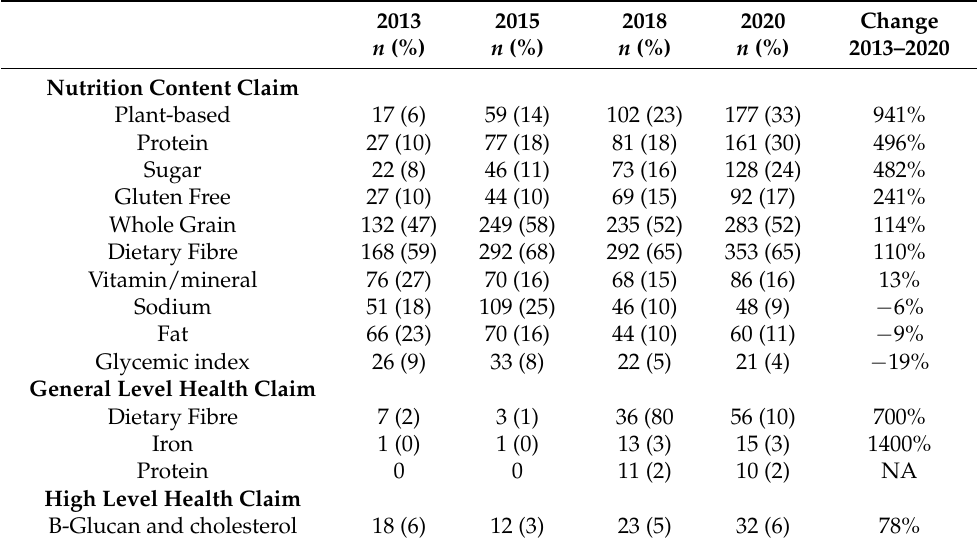
Table 5. Frequency of breakfast cereals displaying nutrition content and health claims in 2013, 2015,